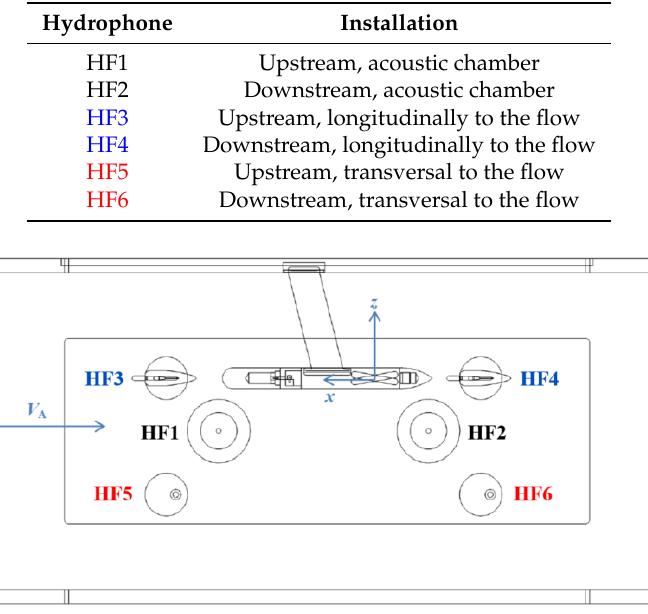
Figure 13. Hydrophone arrangement in the starboard side of the cavitation tunnel. Figure adapted from [32], and reproduced with permission from Rhena Klose